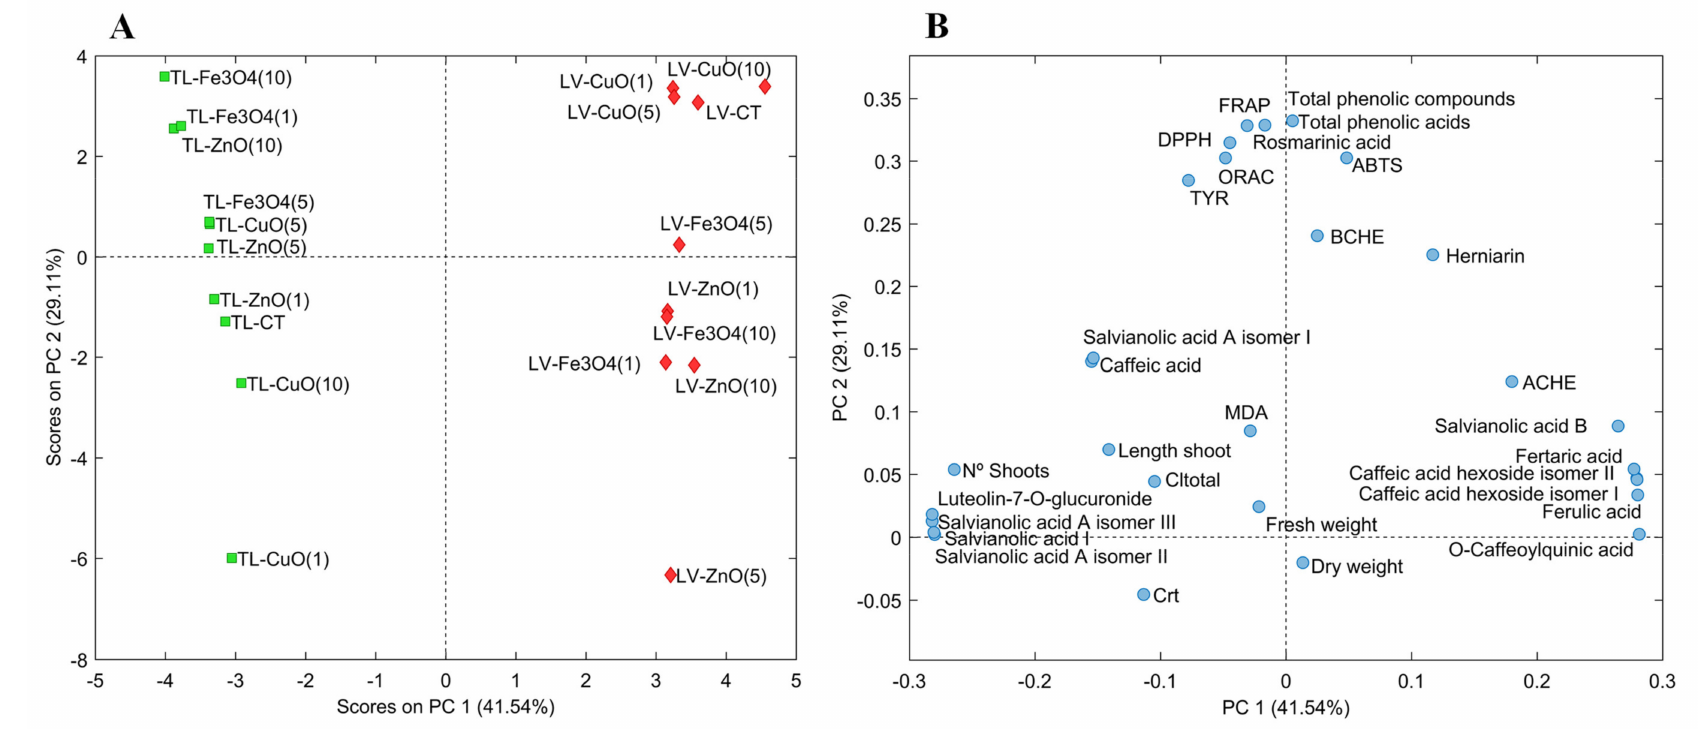
Figure 2. Score plot ( A ) and loading plot ( B ) of principal component analysis (PCA) of extracts from Lavandula viridis L’H é r (LV) and Thymus lotocephalus G. L ó pez and R. Morales (TL) shoots cultured in media with 0 (control), 1, 5 or 10 mg/mL of CuO, ZnO and Fe 3 O 4